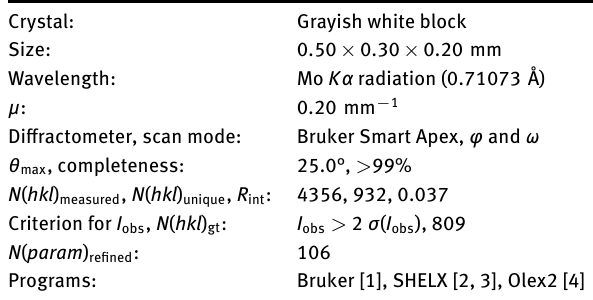
Table 2: Fractional atomic coordinates and isotropic or equivalent isotropic displacement parameters (Å 2 ).